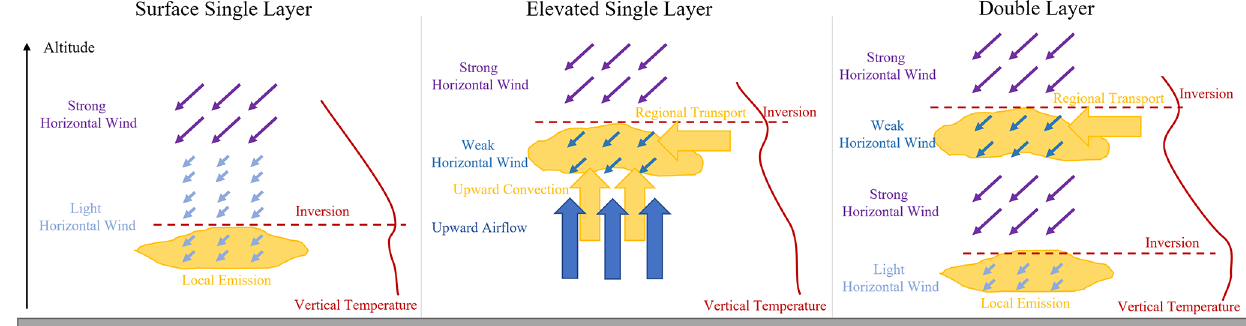
Figure 17. Conceptual model of meteorological elements and vertical distribution of